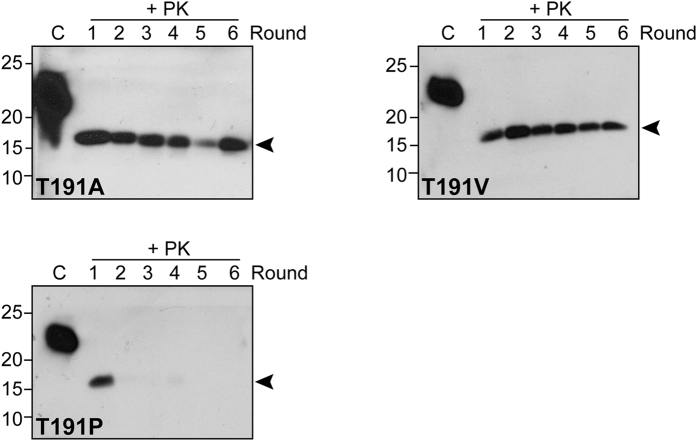
PMCA propagation of recPrion with recombinant PrPT191A, PrPT191V, or PrPT191P as substrate.Each reaction was run for 6 rounds and PMCA products were digested with 50 μg/mL PK at 37 °C for 30 min. PrP was detected by immunoblot analysis with POM1 anti-PrP antibody. “C” indicates undigested recPrP as a control. The original immunoblot images are in the Supplementary Figure S3.